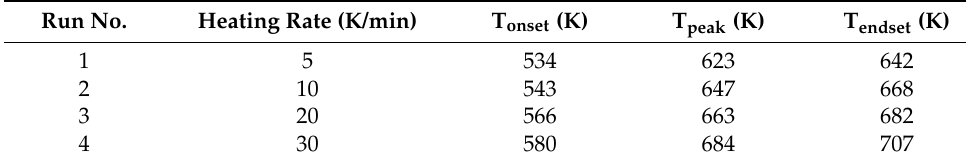
Table 6. Onset, maximum, and end temperatures of pyrolytic cracking characteristics of PLA at different heating rates.